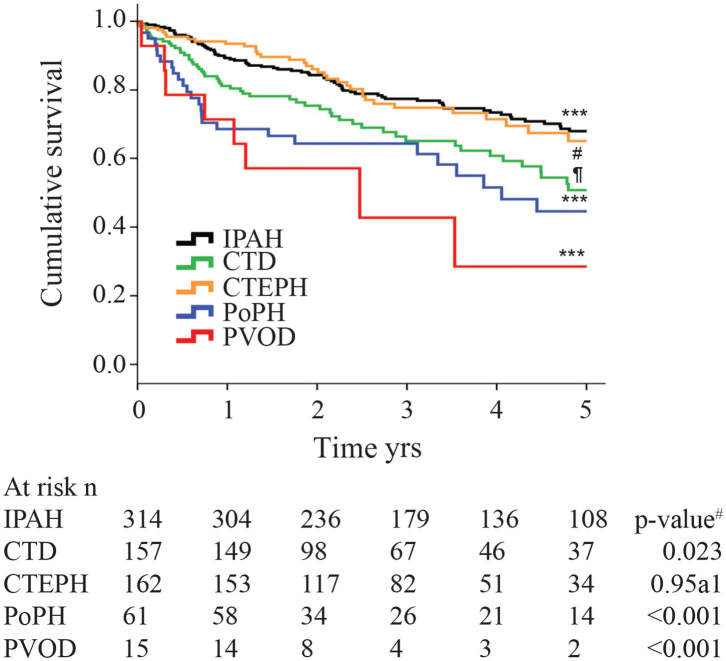
Kaplan-Meier estimates of 5-years survival from time of diagnosis in different pulmonary hypertension subtypes. IPAH, Idiopathic Pulmonary arterial hypertension; CTD, connective tissue disease; CTEPH, chronic thromboembolic pulmonary hypertension; PoPH, portopulmonary hypertension; PVOD, pulmonary veno-occlusive disease. The p-value for the overall comparison is <0.001. # compared with IPAH. Reproduced with permission of the © ERS 2020: European Respiratory Journal 40 (3) 596-603; doi: 10.1183/09031936.00101211 Published 31 August 2012.